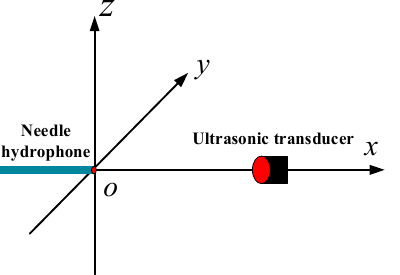
Figure 3. Photo of the ultrasonic transducer for physical simulation. Prior to testing the radiated sound field of the transducer, the spatial distribution of the radiated sound field of the ultrasonic transducer needs to be measured experimentally. The measurement scheme is shown in Figure 4. The normalized sound field distribution obtained by the experiment in the X − Y plane (z = 0 mm) is displayed in Figure 5, where the black dotted line is the contour with a value of 0.7. The range covered by the black dotted line was defined as the acoustic spot range of the transducer. In the following experiment, the distance d from the radiation surface of the transducer to the surface of the reflection plate (Figure 6) was 25–30 mm, and the width (sound spot diameter) in the Y direction was about 8 mm.